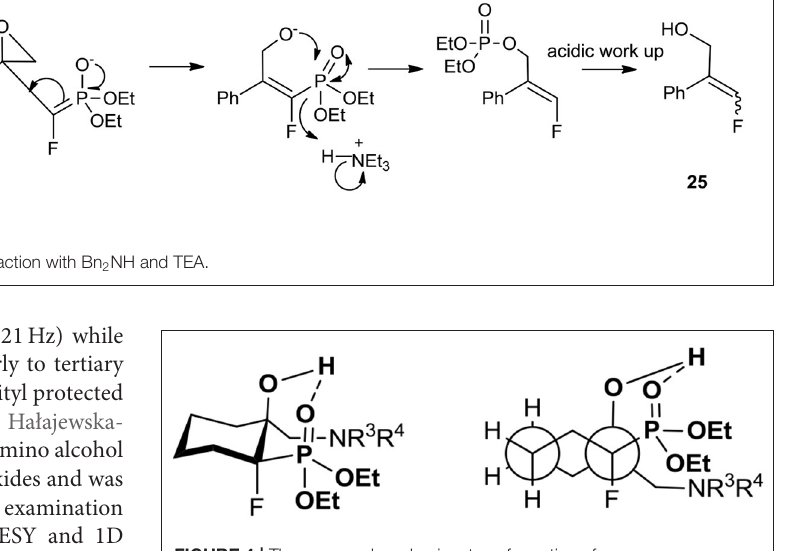
Azoulay et al., 2005; Wu and Xia, 2005; Padwaa and Murphree, 2006; Fustero et al., 2011; Singh et al., 2013). The analogous reaction of optically active ( S )-2,3-epoxypropylphosphonate with Bn 2 NH almost exclusively gave one ( S )-enantiomer of amino alcohol (Wróblewski and Hałajewska-Wosik,